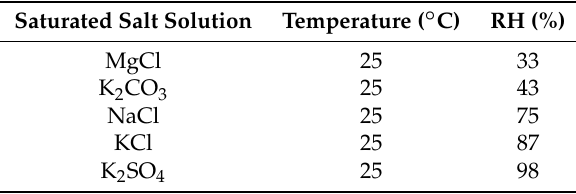
Table 1. Relative humidity (RH) values of normally used saturated salt